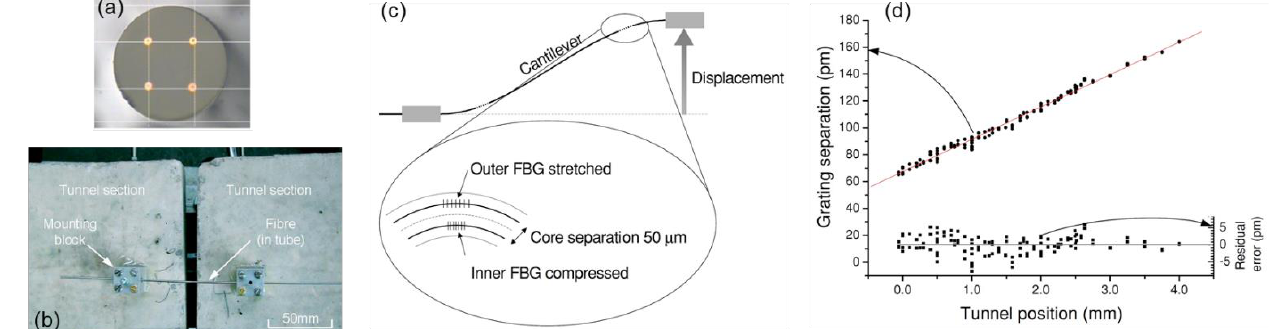
Figure 16. ( a ) Cross-section of MCF used in this experiment; ( b ) cantilever containing MCF attached to tunnel lining; ( c ) FBG pairs act as curvature sensors — the curvature is determined from the strain difference between the gratings; ( d ) experimental results from translation tests. Adapted with permission from Ref. [48].